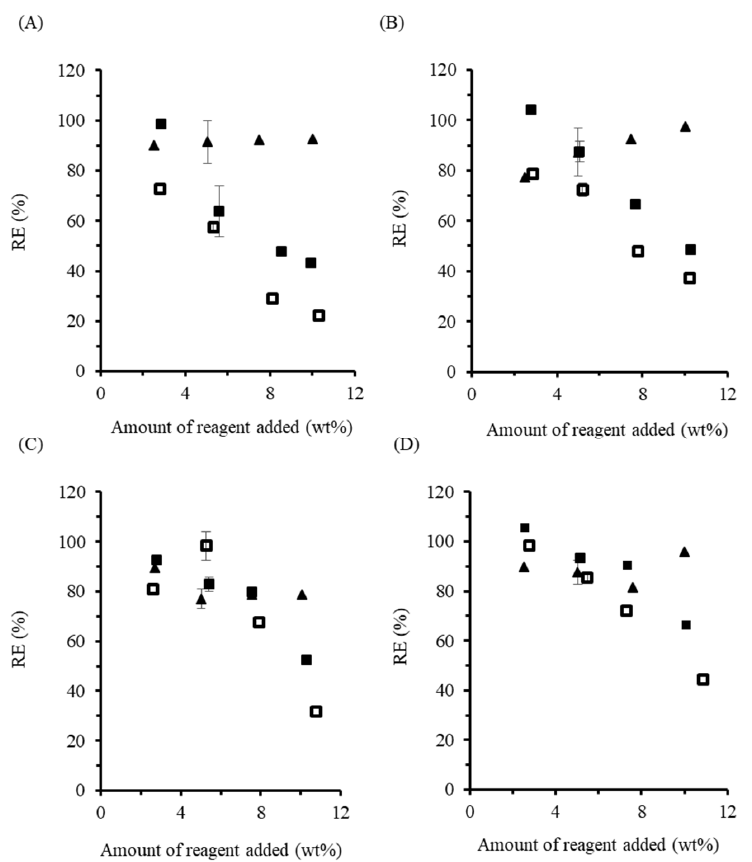
Figure 6. Modification of starch with ( A ) TENAX 2010, ( B ) MSO-1.1, ( C ) MSO-2.2, and ( D ) MSO-2.3. Conversion at different weight loadings for ( ▲ ) dispersed starch and melt mixer reactions ( □ ) without and ( ■ ) with base.